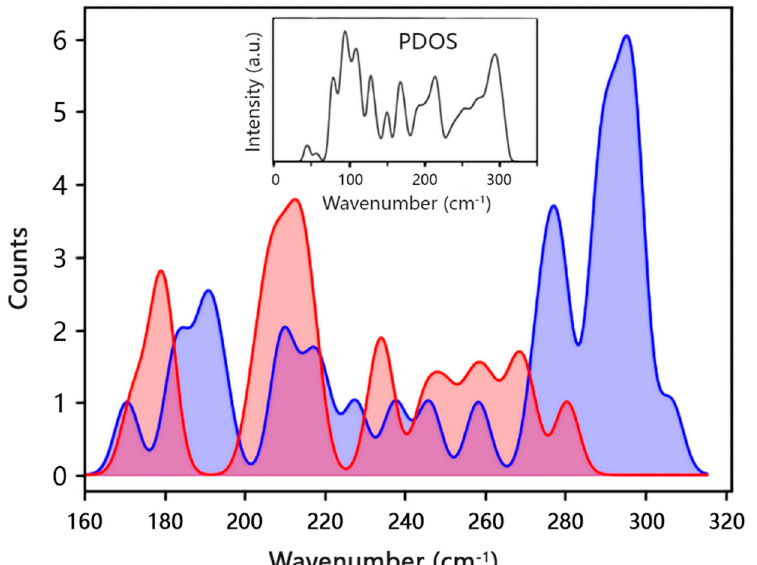
Figure 2. Fitted curves of two-bond modes (red) and four-bond modes (blue) in hydrogen-disordered ice Ic. Inset: The PDOS spectrum in the translation region.